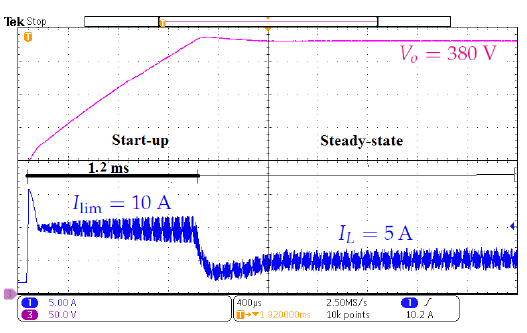
Figure 19. Startup and steady-state responses of the system from experimental measurements.